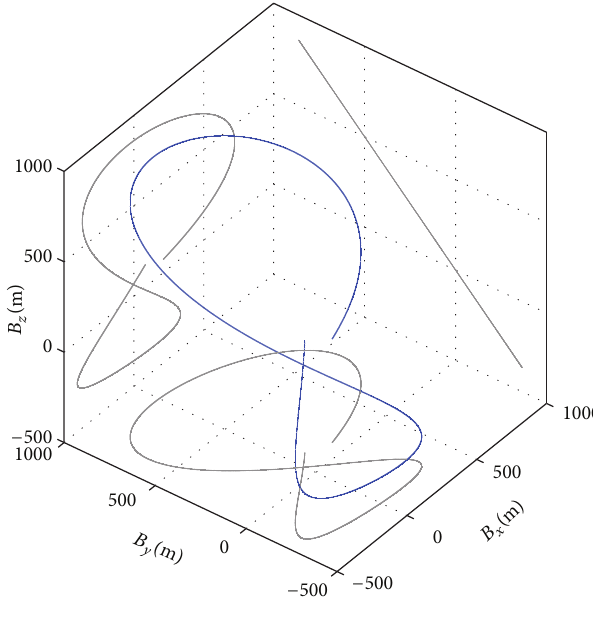
Figure 2: Variation of the baseline in ORF during a single orbit for the selected helix